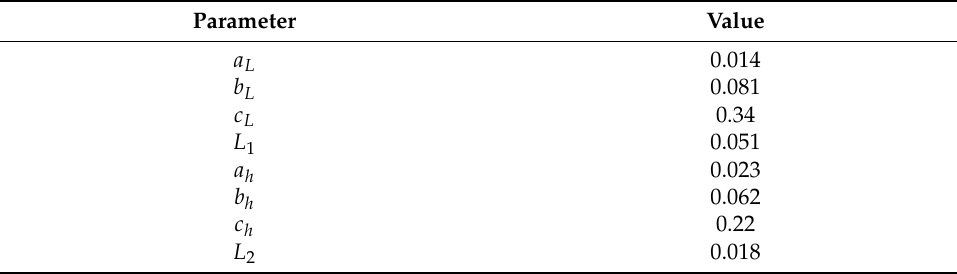
Table A2. Control parameters used in this